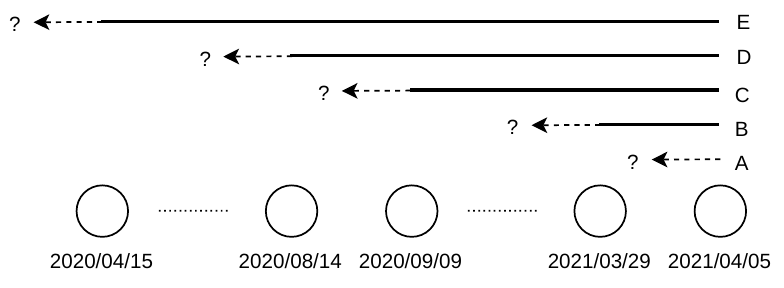
Figure 8. Interval censoring. A—address location changed within a week to past; C—address